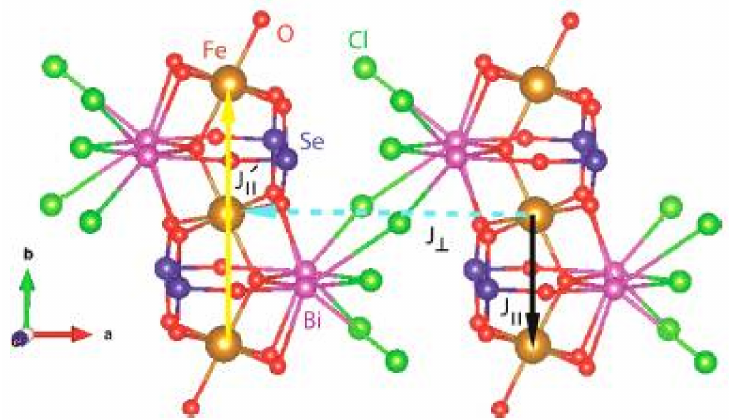
Figure 13. Exchange paths for various magnetic interactions J (cid:107) (in black), J (cid:107)(cid:48) (in cyan), and J ⊥ (in gold) in Bi 2 Fe(SeO 3 ) 2 OCl 3 . Reprinted with permission from [30]. Copyright (2014) American Chemical